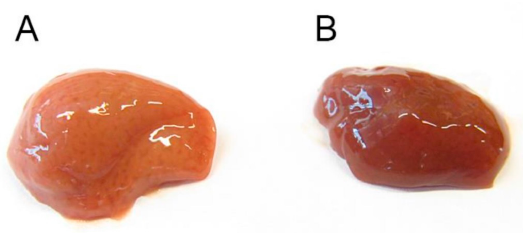
Figure 14. Morphological appearance of liver of ( A ) non-treated db/db mouse and ( B ) deh-T3 β -treated db/db mouse liver.